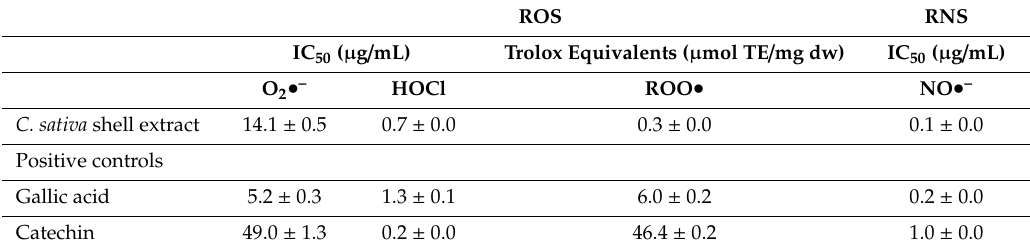
Table 4. Superoxide anion radical (O 2 • – ), hypochlorous acid (HOCl), peroxyl radical (ROO • ) and nitric oxide (NO • – ) scavenging capacities of optimal C. sativa shells extract. Values are expressed as mean ± standard deviation ( n =